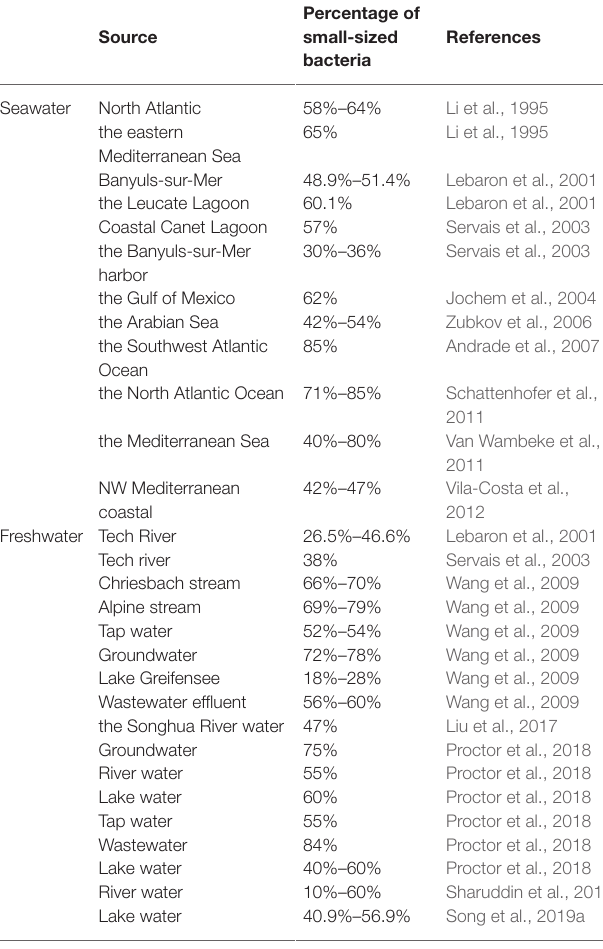
TABLE 3 | Distribution of LNA bacteria in diverse